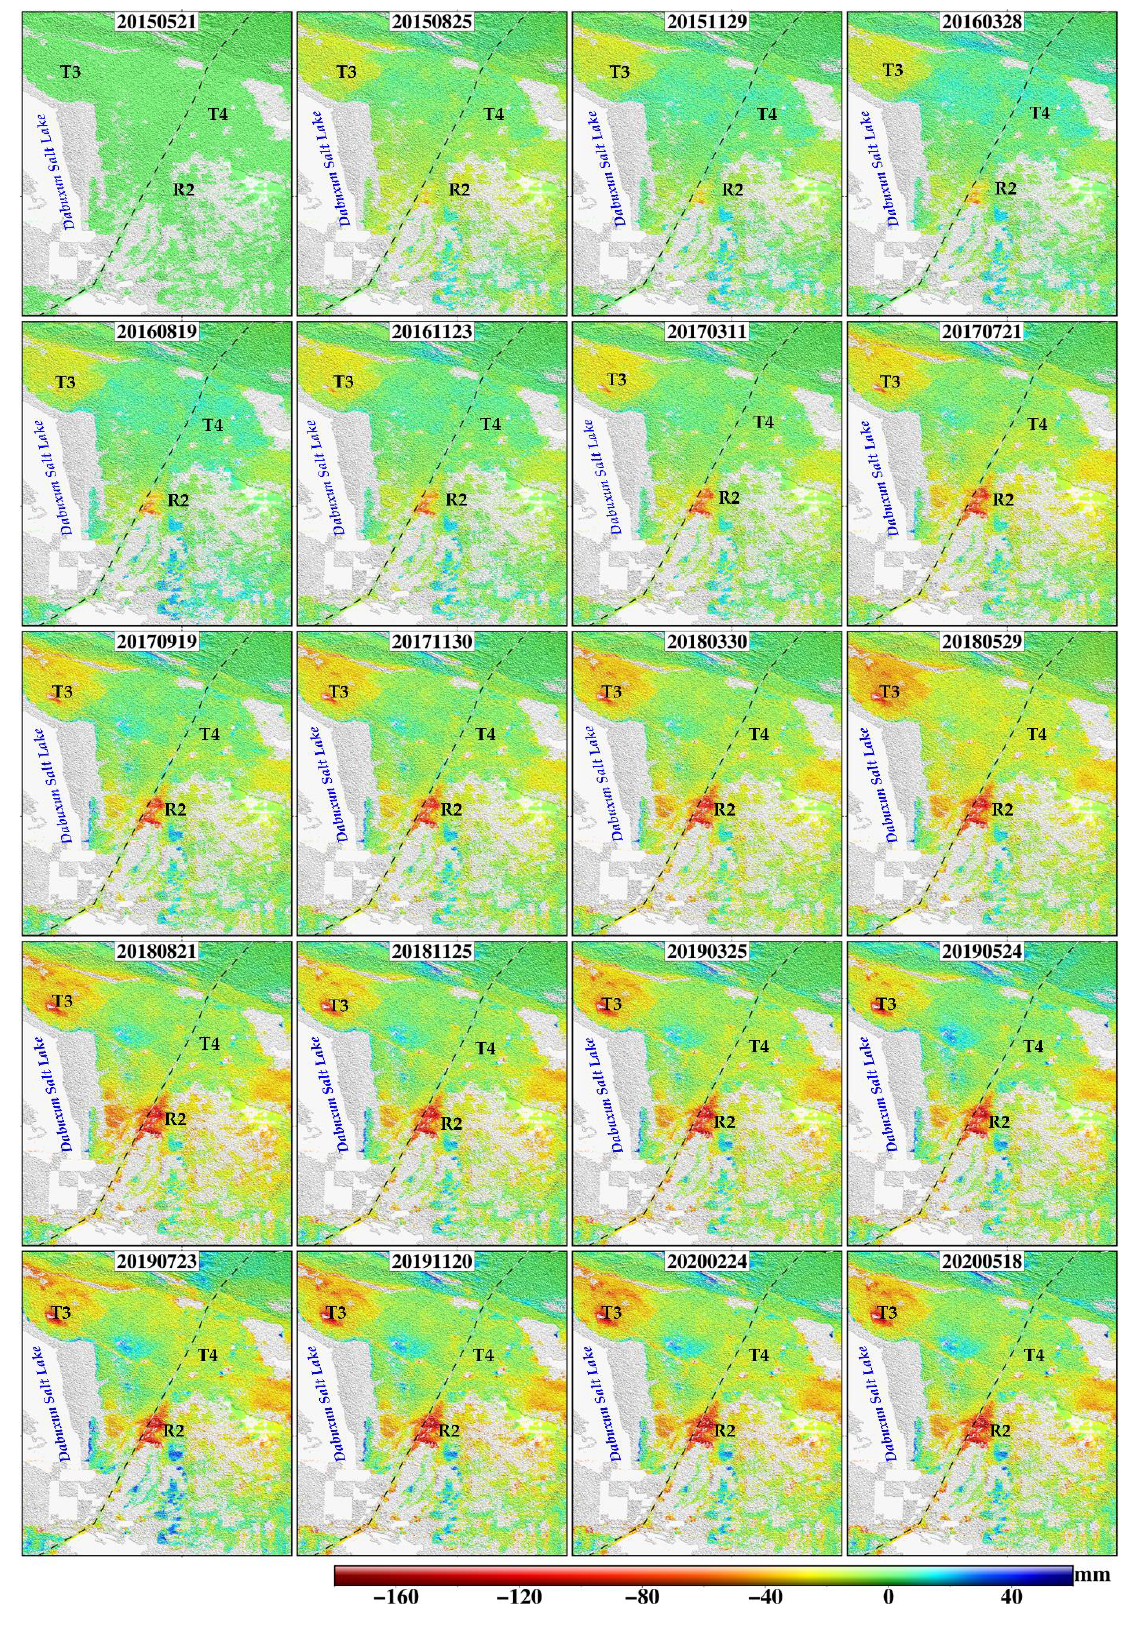
Figure 12. The accumulated deformation maps of area (b) from May, 2015 to May, 2020, each subplot is depicted with about 3 months’ increments from the deformation results of TS-InSAR.